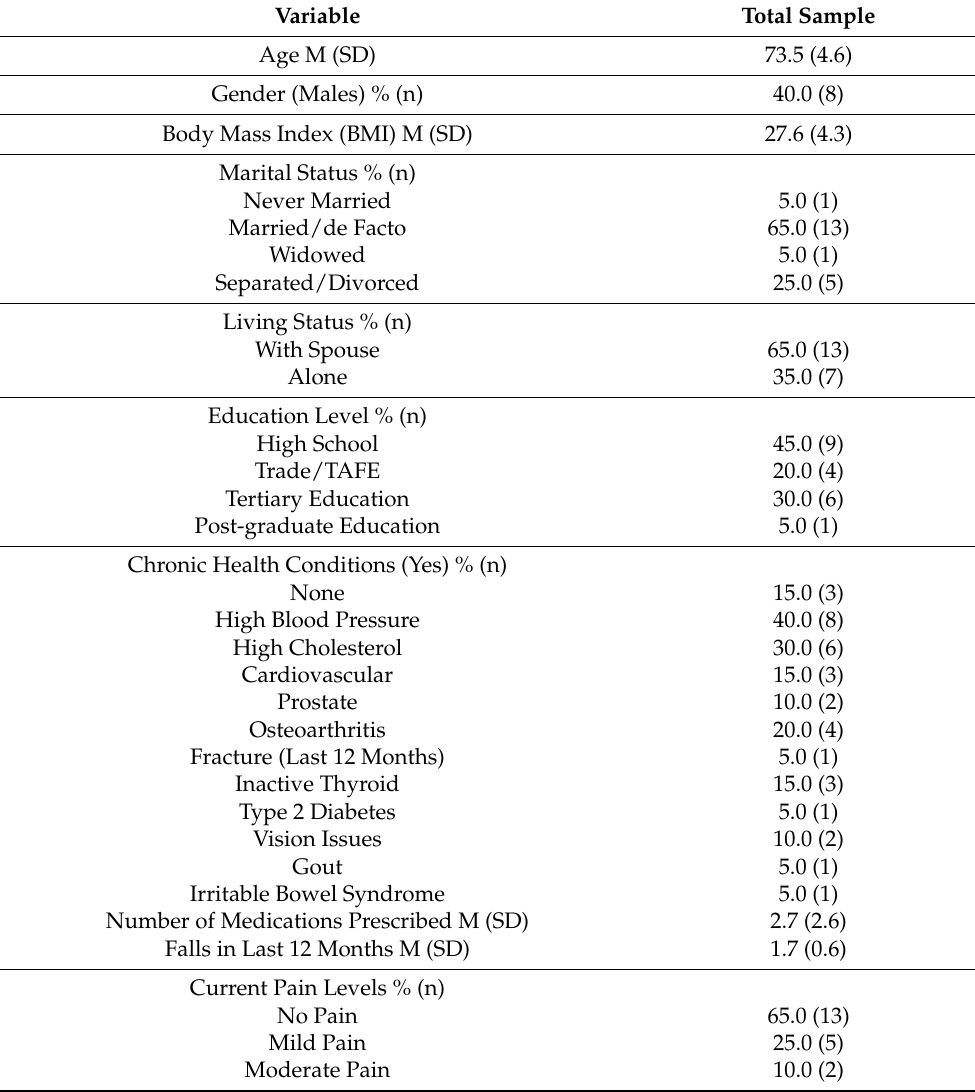
Table 1. Participant